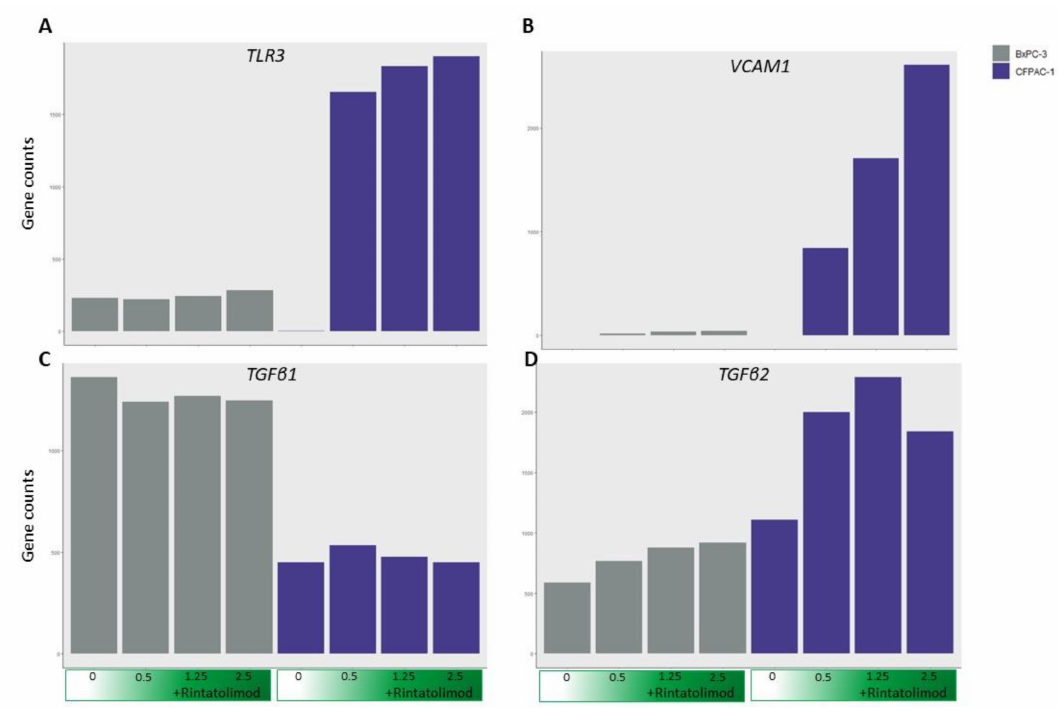
Figure 5. Treating cancer cells with Rintatolimod did not upregulate genes involved with fibrosis. The expression of TLR3 ( A ) was upregulated in CFPAC1 cells after treating with Rintatolimod. The expression of VCAM1 ( B ) and TGF β 2 ( D ) was upregulated by Rintatolimod. However, no upregulation of TGF β 1 ( C ) was observed after treating with Rintatolimod in both cell